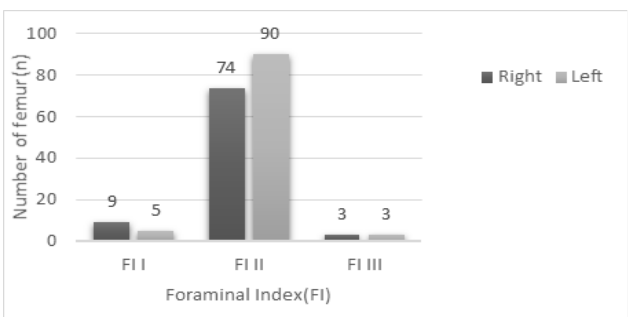
Fig. 1. Foraminal Index of the Femur.